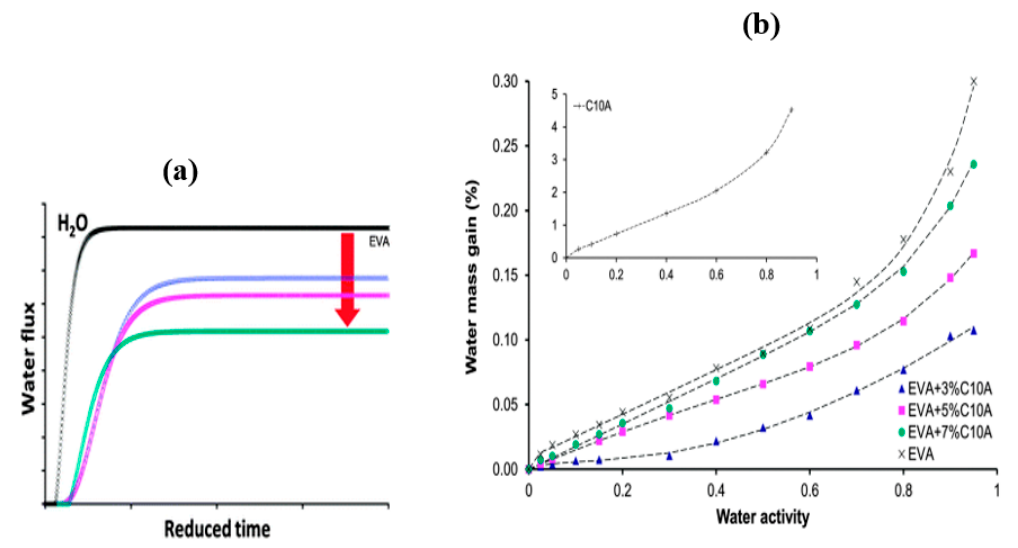
Figure 19. ( a ) Water permeation flux as a function reduced time. ( b ) Water vapor sorption isotherms of the neat EVA matrix and its nanocomposites with an inset of C10A nanoclay isotherm. The dotted lines correspond to the fitting of experimental data with Park’s model. Reproduced with permission from Reference [169]. Open Access 2015, The Royal Society of Chemistry.